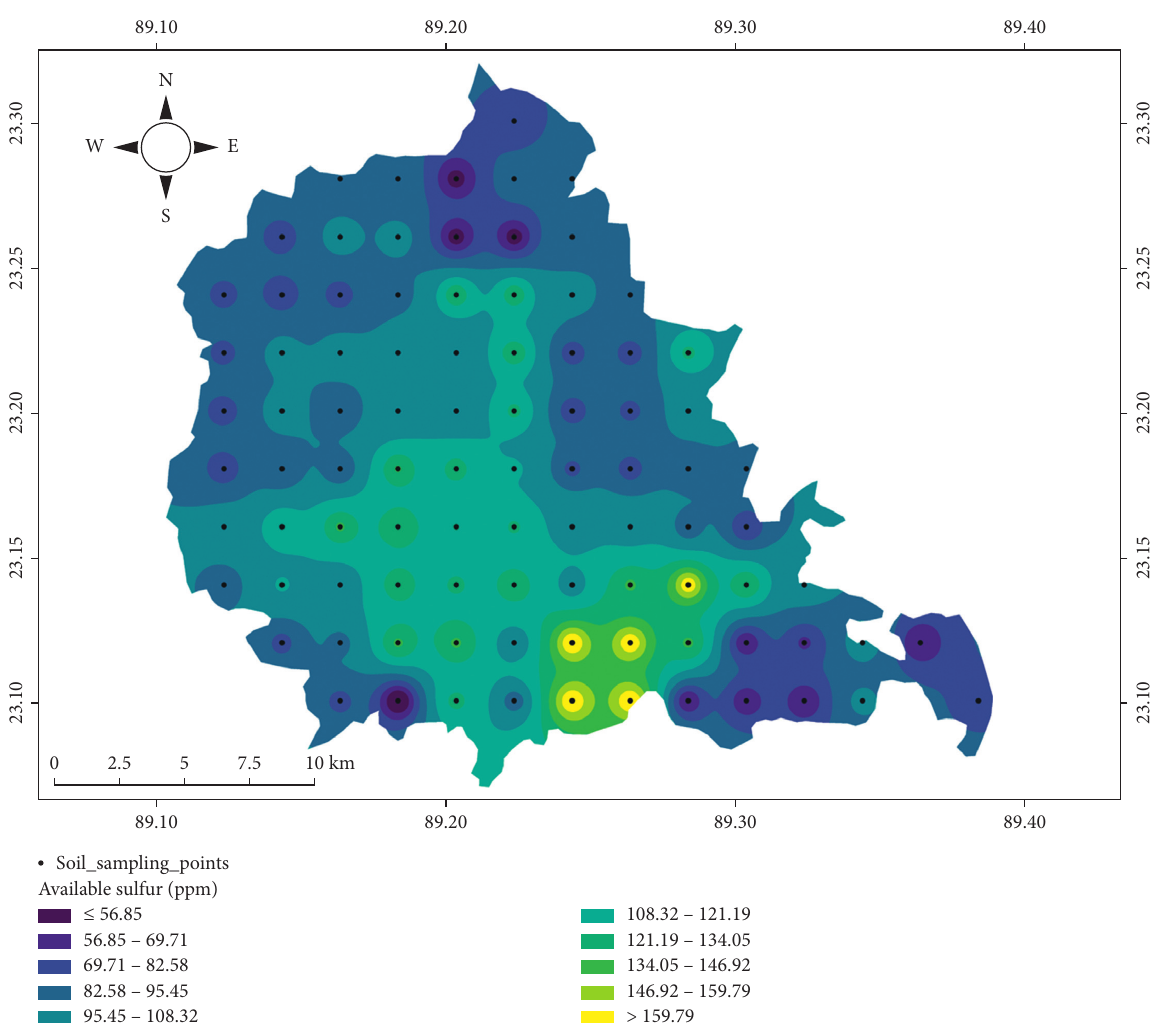
Figure 11: Spatial distribution of available soil sulfur (Av S) contents in the study